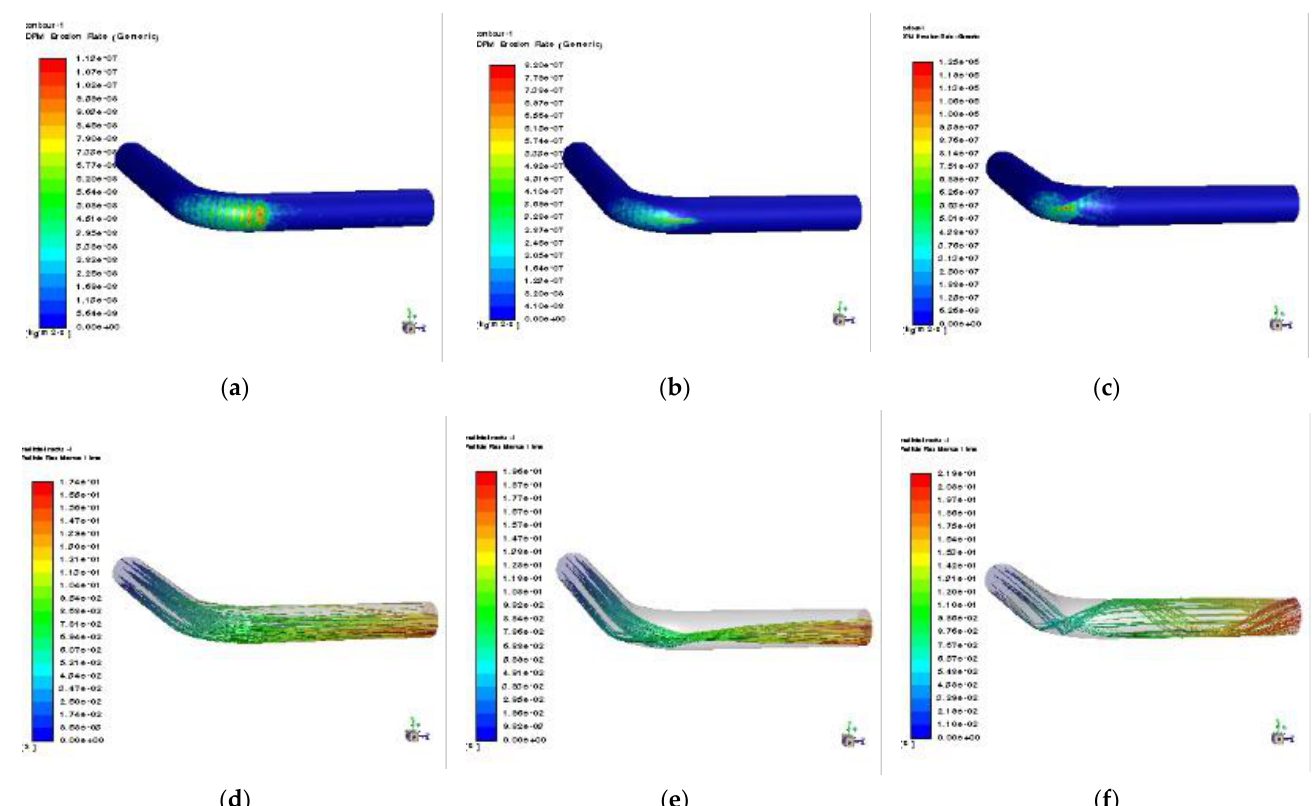
Figure 11. Erosion rate distribution and particle trajectories in the elbow with different particle diameter. ( a ) erosion rate distribution of 25 μm; ( b ) erosion rate distribution of 100 μm; ( c ) erosion rate distribution of 500 μm; ( d ) particle trajectories of 25 μm; ( e ) particle trajectories of 100 μm; and ( f ) particle trajectories of 25 μm.